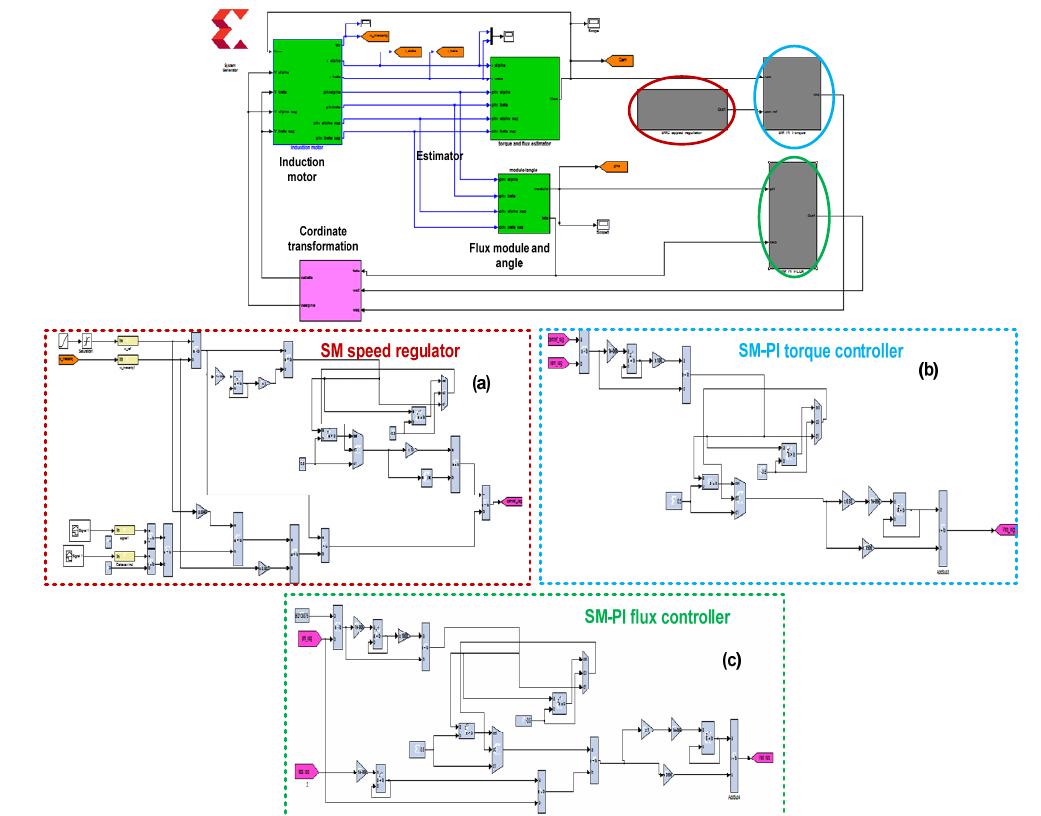
Figure 12. DTC − SM modeling using XSG toolbox: ( a ) speed regulation loop using SM controller; ( b ) SM − PI torque regulator; ( c ) SM − PI controller dedicated to stator flux.